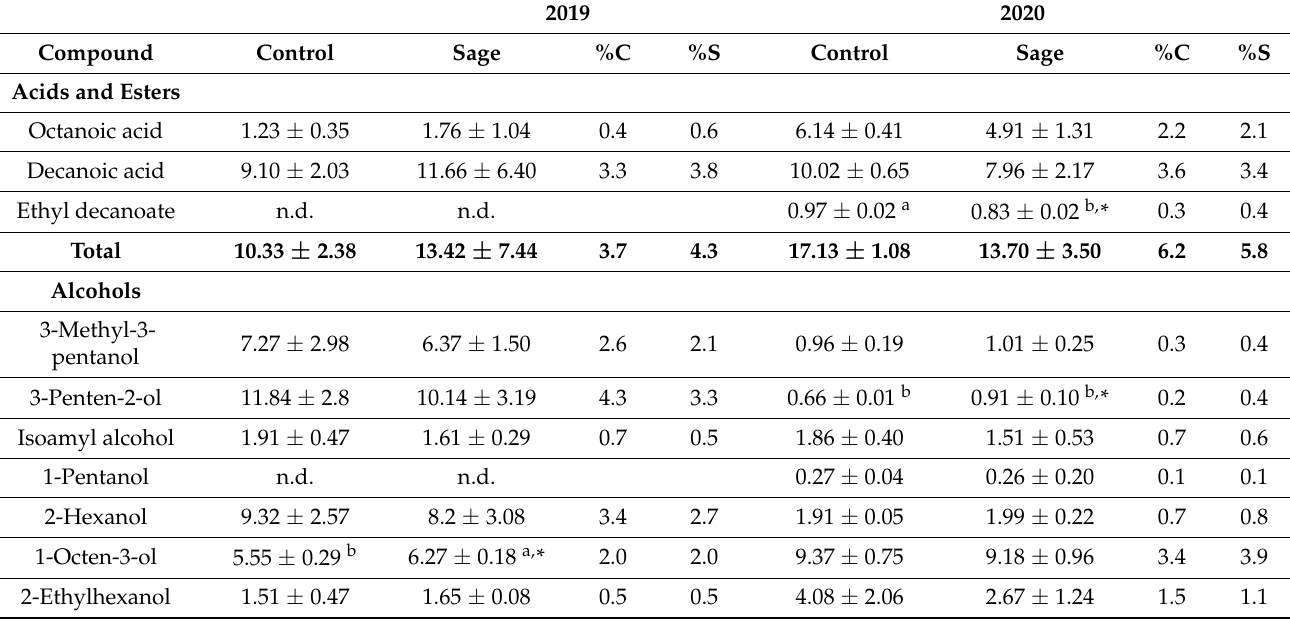
Table 4. Concentration ( µ g kg − 1 fw) and percentage of glycosylated volatile organic compounds detected in cv. Trebbiano Romagnolo